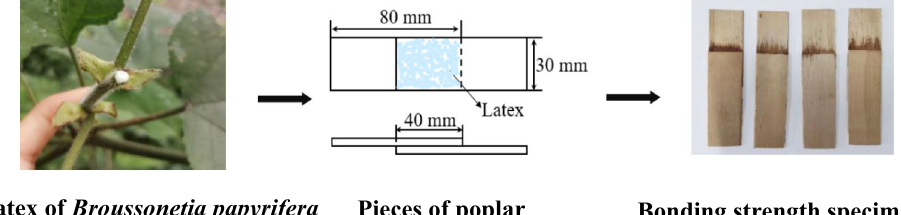
Fig. 3 Preparation of bonding specimens by bonding poplar veneer with Broussonetia papyrifera